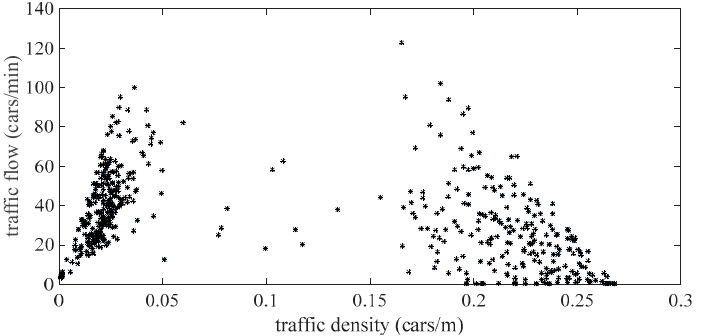
Figure 7. Relationship between traffic density and traffic flow simulated by SUMO in this paper.